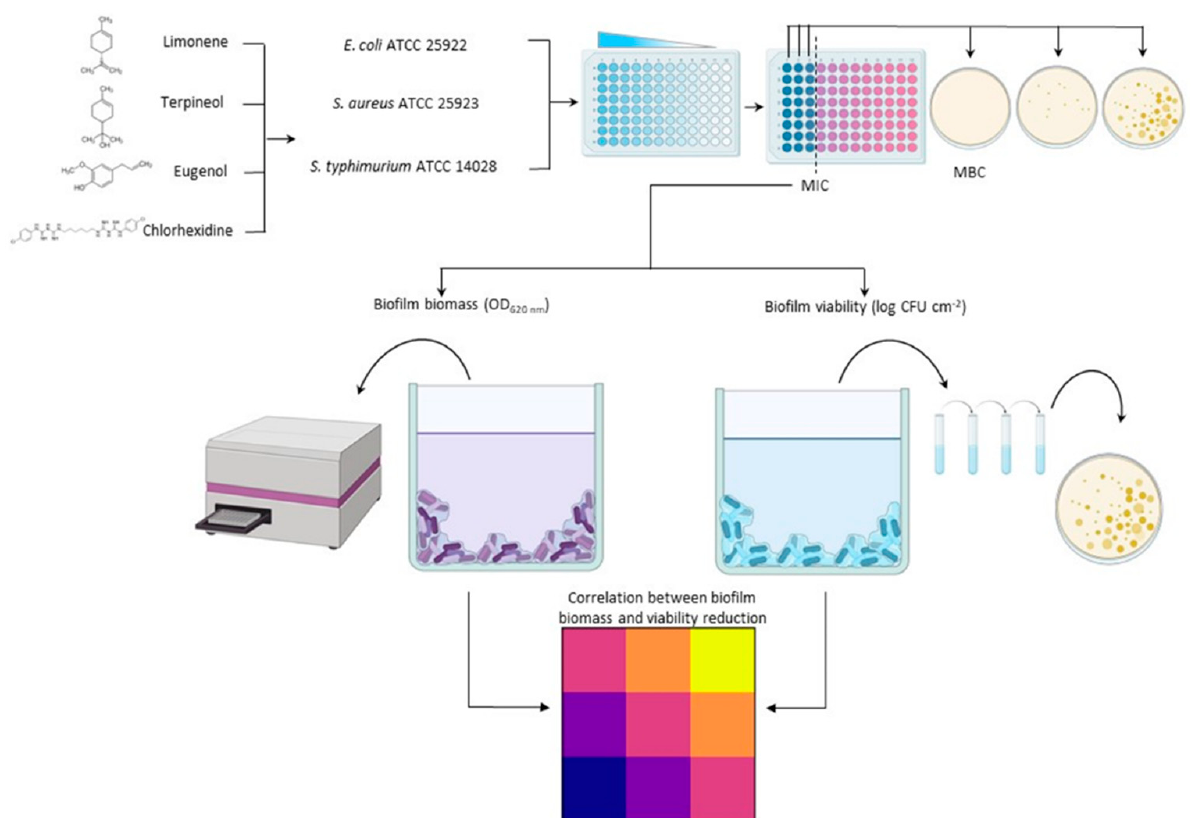
Figure 1. Research design testing antibacterial and antibiofilm potential of limonene, terpineol, eugenol and chlorhexidine against E. coli , S. typhimurium and S. aureus biofilm biomass and viability (Created with BioRender.com).